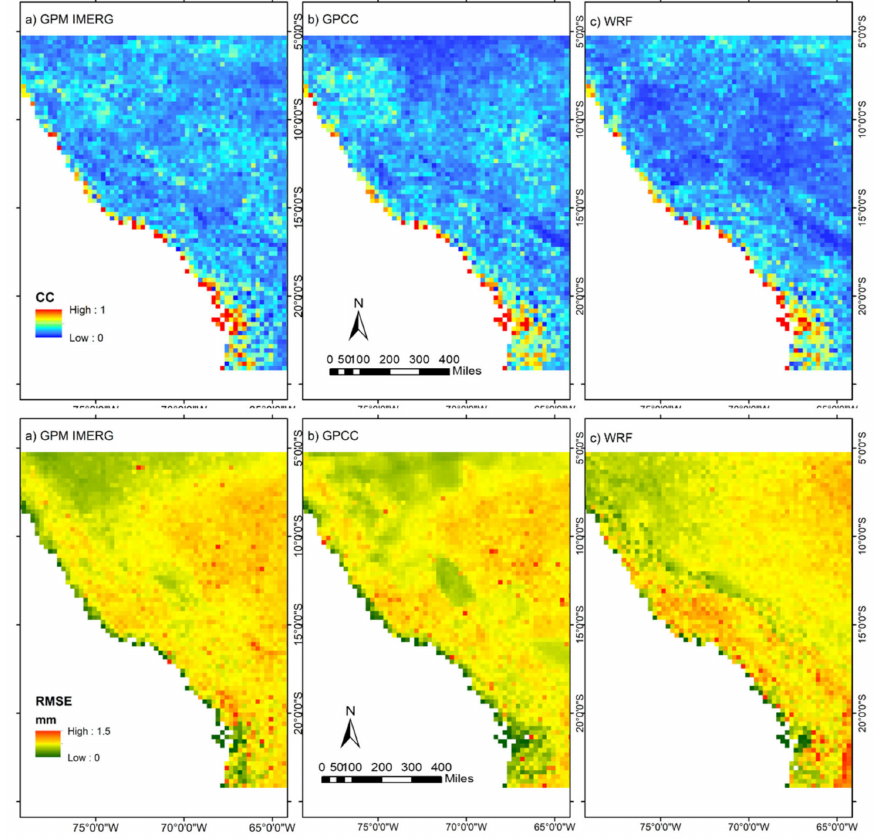
Figure 8. The MTC analysis results (CC and RMSE) between ( a ) GPM IMERG, ( b ) GPCC, and ( c ) WRF at a monthly time scale from 2010 to